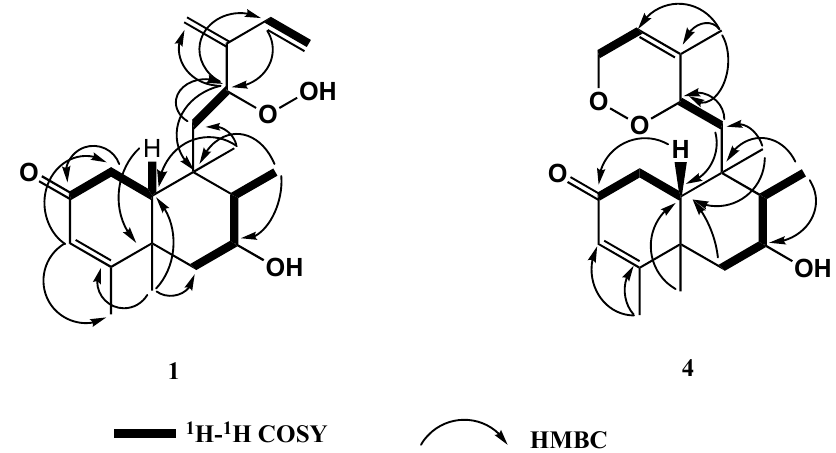
Figure 2. Observed 1 H- 1 H-COSY and HMBC correlations for 1 and 4.